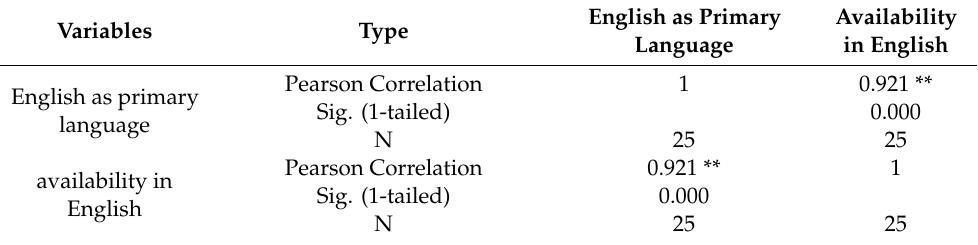
Table 7. Pearson’s correlation coe ffi cient (English as primary language—availability in English). Variables